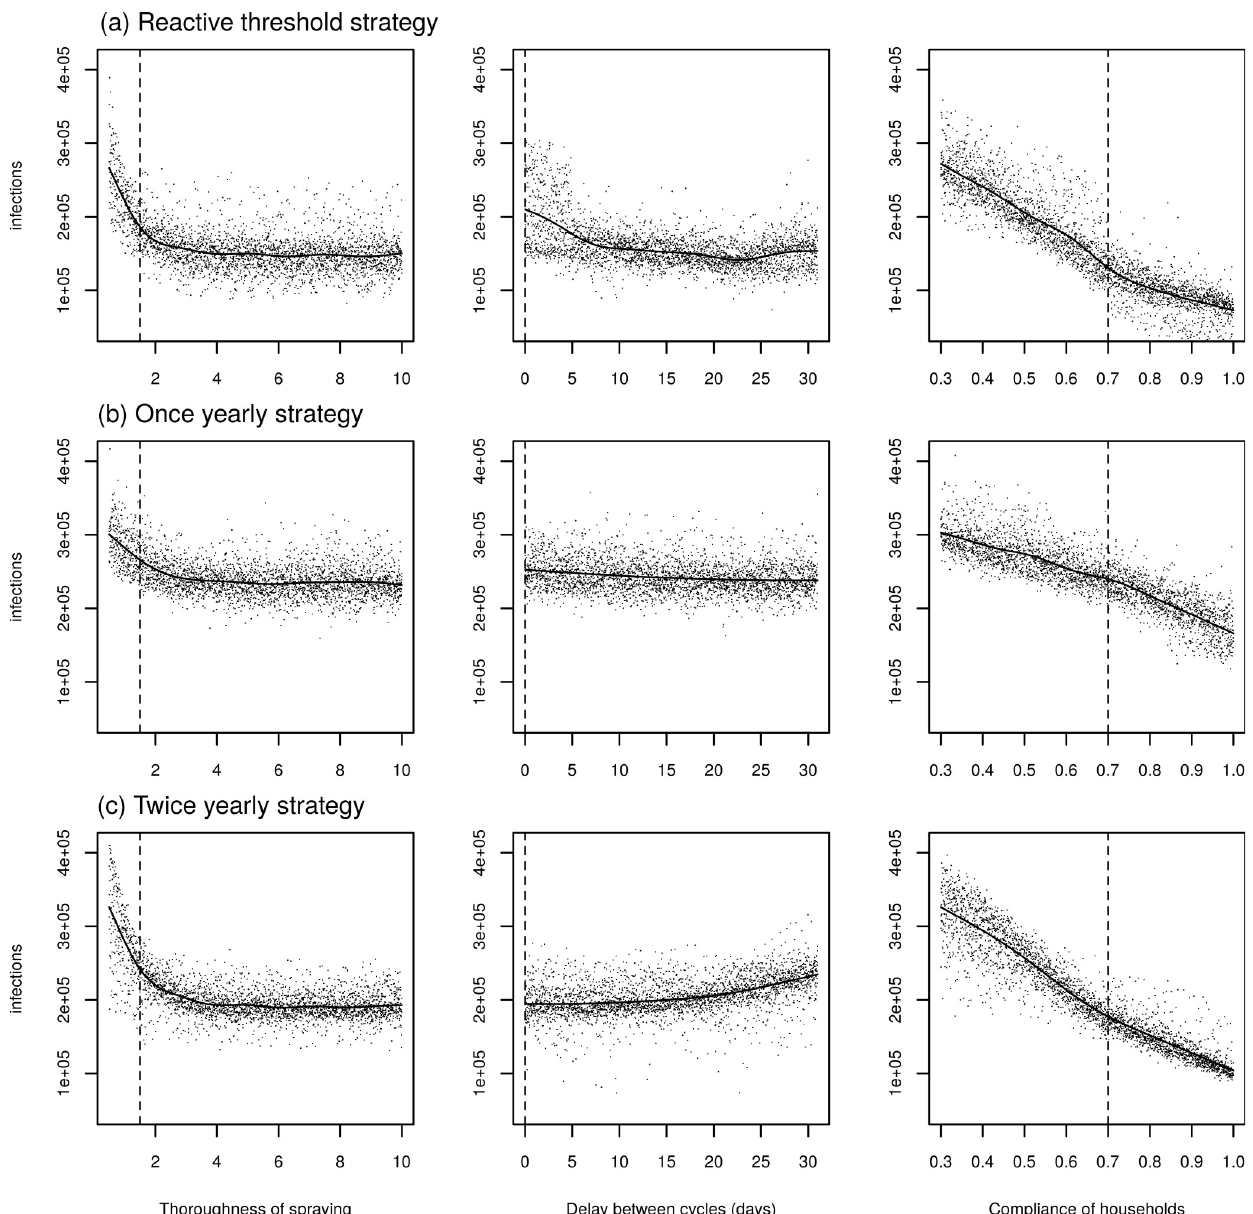
Fig 10. Sensitivity analysis jointly varying the thoroughness of ULV spraying (i.e., the increase in mosquito mortality rate on the day of spraying) (left column), the delay, in days, between cycles (middle column), and the compliance of households. The first row shows the results using the best adaptive threshold strategy (starting spraying when the monthly incidence is more than one standard deviation above the mean for that month for the last five years), the second row using the best yearly strategy (spraying in September) and the bottom row the best twice yearly strategy (spraying in September and November). Each point represents a model simulation, and the line represents a fitted generalized additive model. Vertical dashed lines show the value used in the baseline